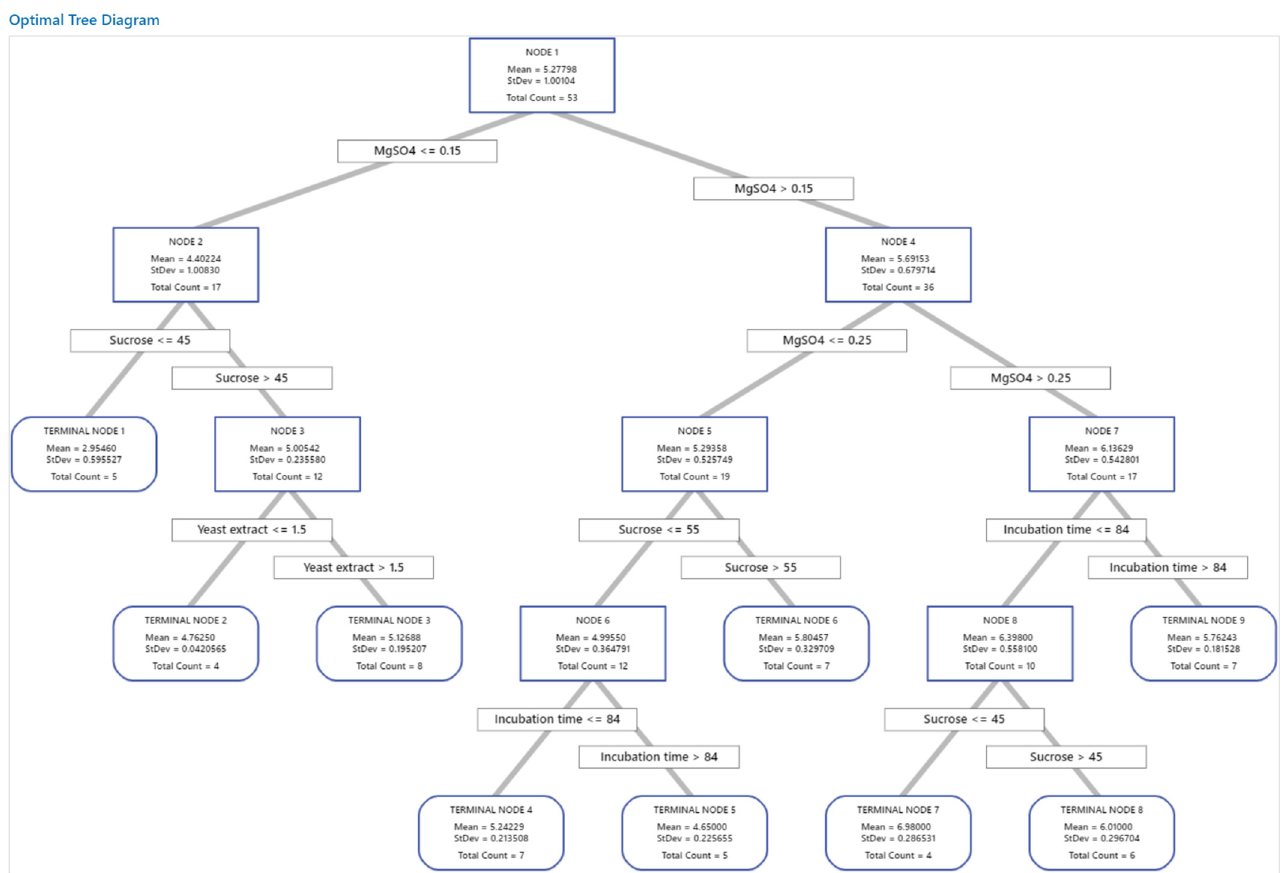
Figure 6. The decision tree with a depth of four of the pullulan biosynthesis using A. pullulans . A total of 81 data sets from Taguchi’s experimental design were employed in the decision tree learning algorithm to predict pullulan yield. The data used for node selection are introduced in the squares. The squares involved in the paths of the best variable mixtures for pullulan biosynthesis were predicted with the decision tree.